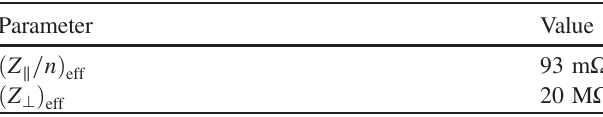
TABLE II. Impedance budget for LHC [17].